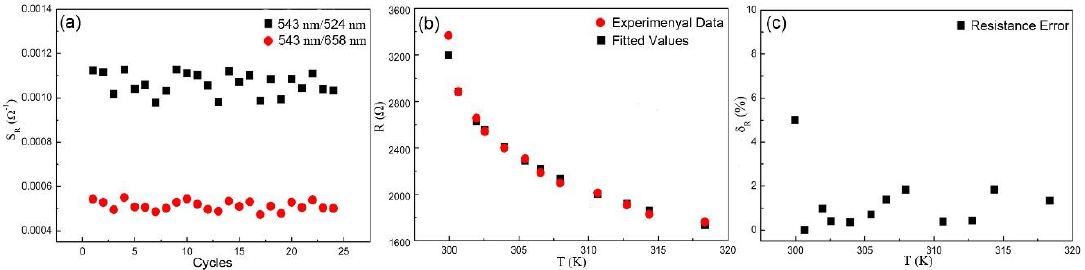
Figure 7. Sensitivity characterization of the sensor. ( a ) Dependence of relative sensitivity S R on the number of cycles. ( b ) The fitted and experimental data points showing the dependence of the resistance on temperature. ( c ) Dependence of the resistance error δ R on temperature.